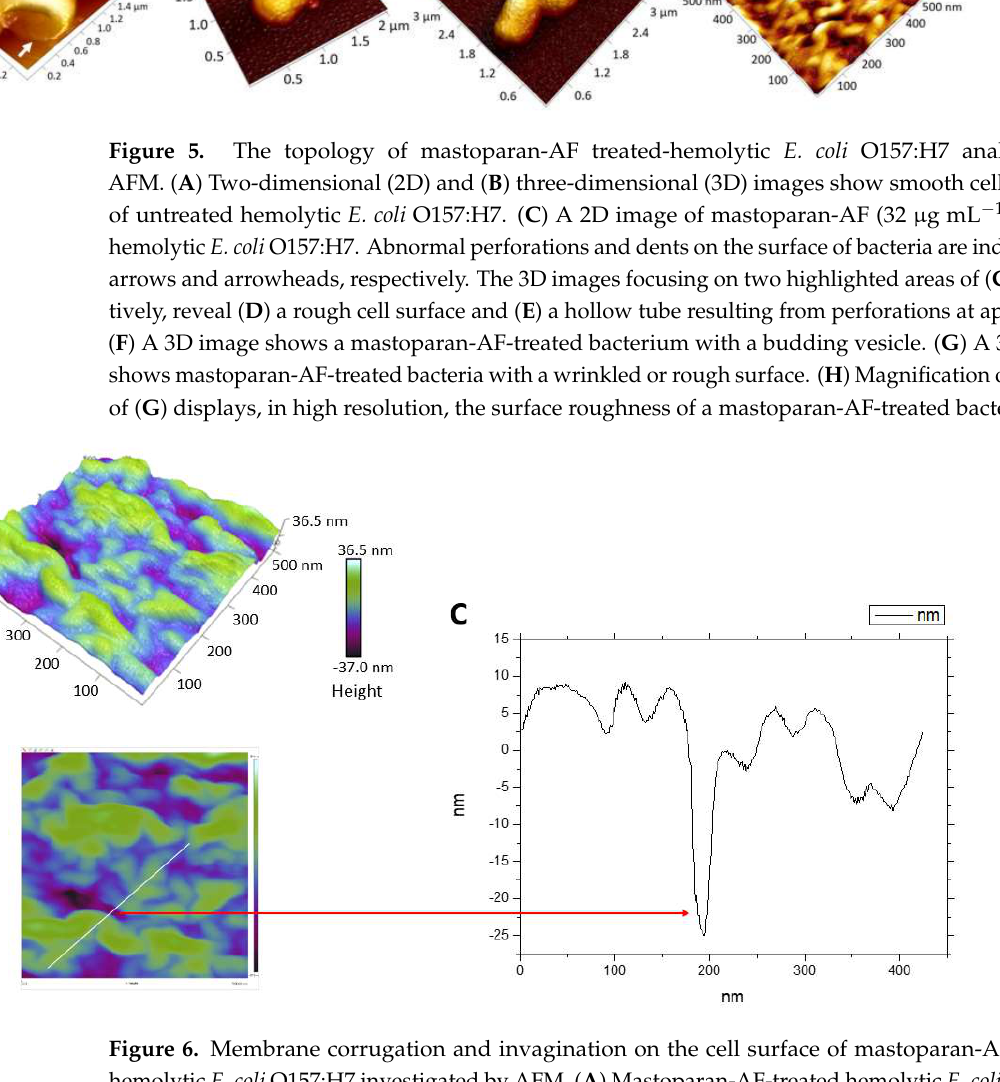
Figure 6. Membrane corrugation and invagination on the cell surface of mastoparan-AF-treated hemolytic E. coli O157:H7 investigated by AFM. ( A ) Mastoparan-AF-treated hemolytic E. coli O157:H7 with rough surface was viewed from the top. The height of cell surface ranges from 36.5 nm to −37 nm. Purple and dark purple colors indicate deep pits or invaginated areas. ( B ) Cross-sectional analysis was performed (marked in white). ( C ) A cross-section view reveals membrane corrugation and invagination. An invaginated pit was measured as 25 nm deep.